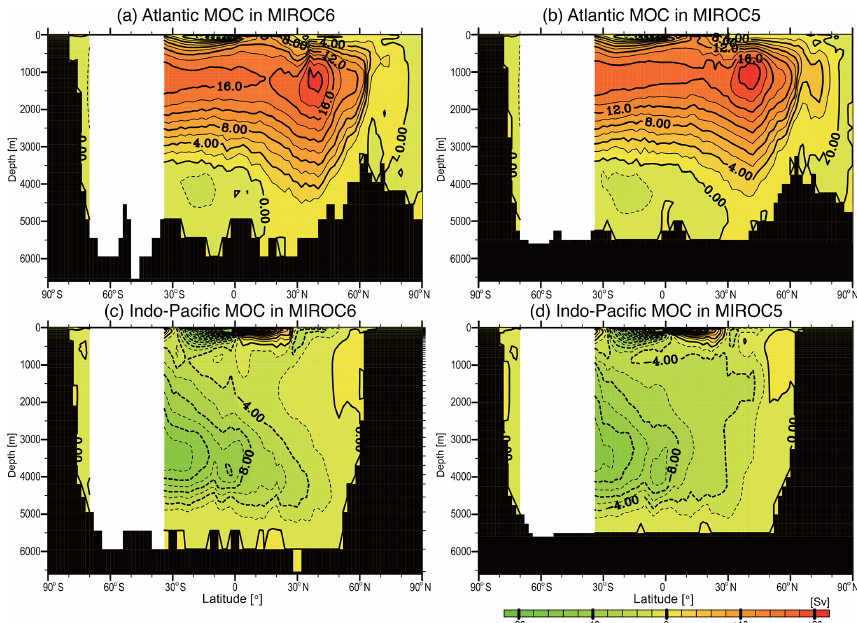
Figure 16. Annual mean meridional overturning circulation in the Atlantic (a, b) and the Indo-Pacific sectors (c, d) in MIROC6 (a, c) and MIROC5 (b, d) . The unit is the sverdrup (Sv; ≡ 10 6 m 3 s − 1 ).